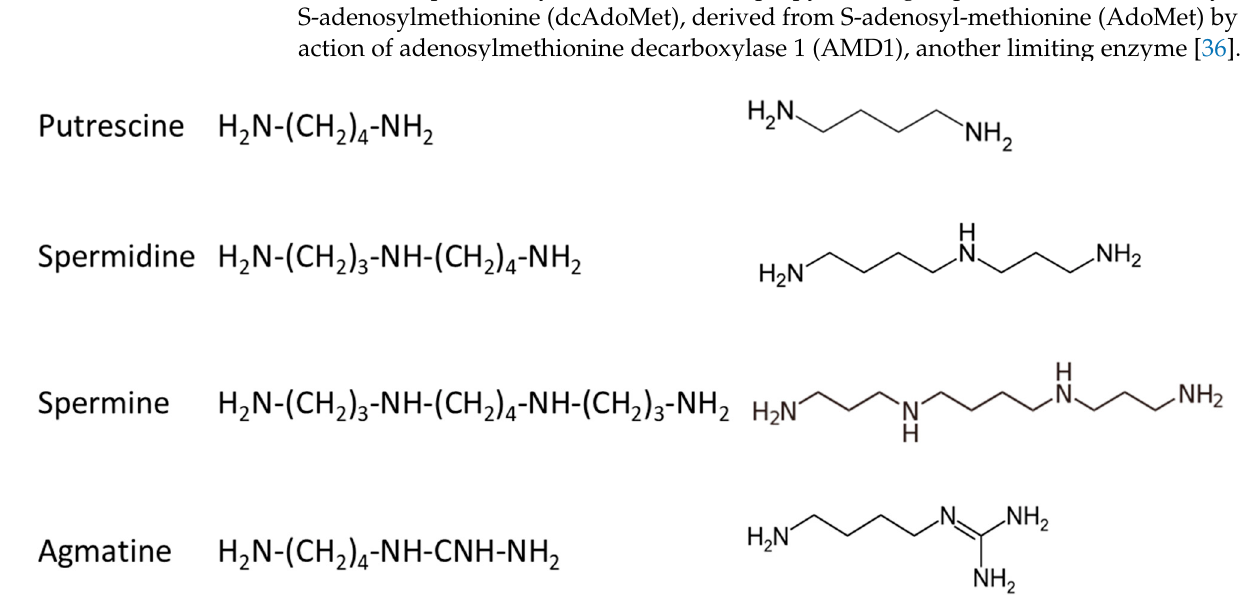
Figure 5. Structure of polyamines identified in mammalian cells.